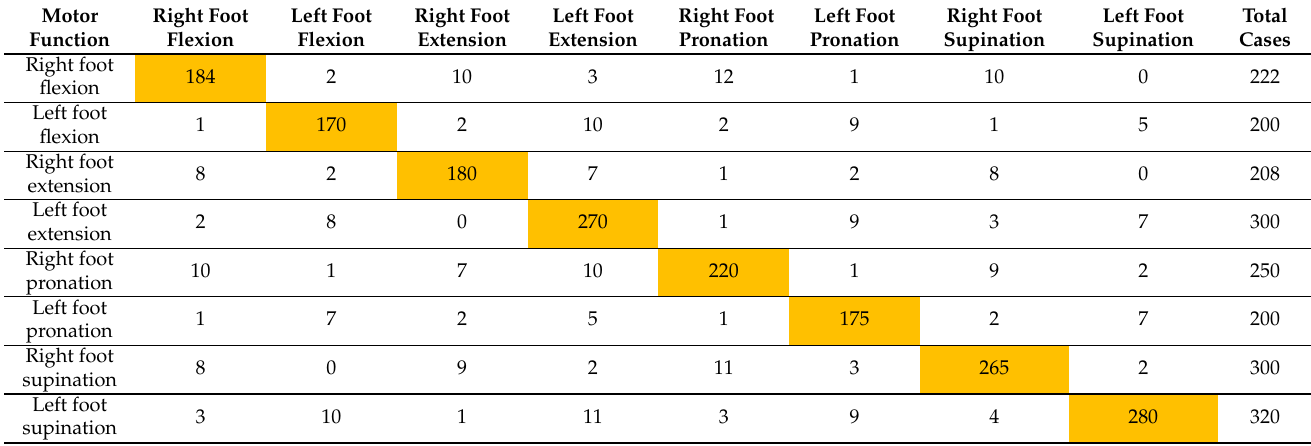
Table 9. Confusion matrix for the proposed DL model with transfer learning with one source domain.